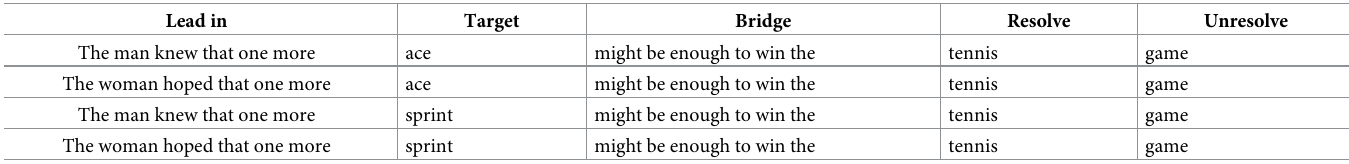
Table 3. Example sentence input to the MEG subject and